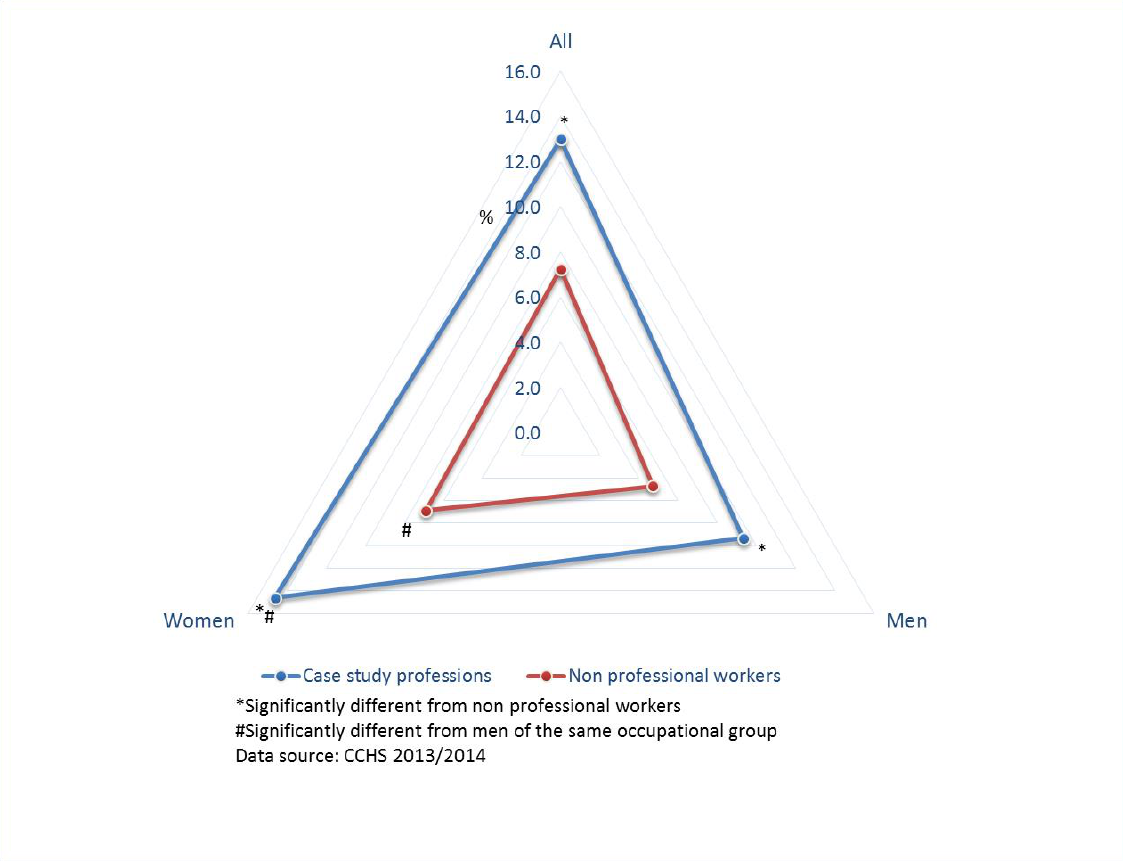
Figure 4. Higher rates of work absence (last week) were reported among CSP workers than among non-professional workers. Also, higher work absences were found in female CSP workers than male